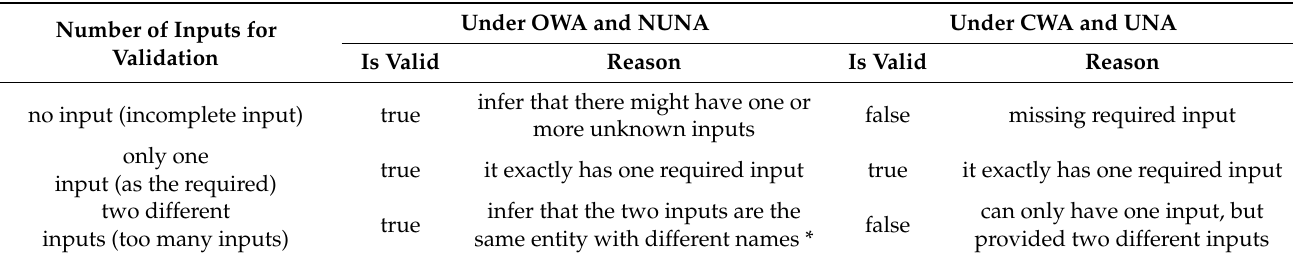
Table 1. The differences in the results of data validation under OWA-NUNA versus those under CWA-UNA against a cardinality constraint that the parameter must have only one